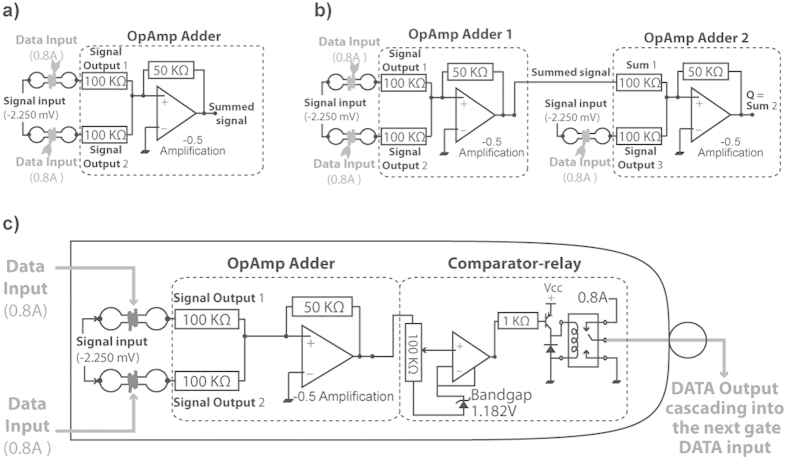
Circuit diagrams of hybrid H-tube/electronic circuitry.(a) Summing adder comprising two H-tubes feeding into a summing amplifier. (b) 3-way summing amplifier circuitry. (c) Bio-logic gate comprised of summing amplifier connected to a comparator-relay unit.